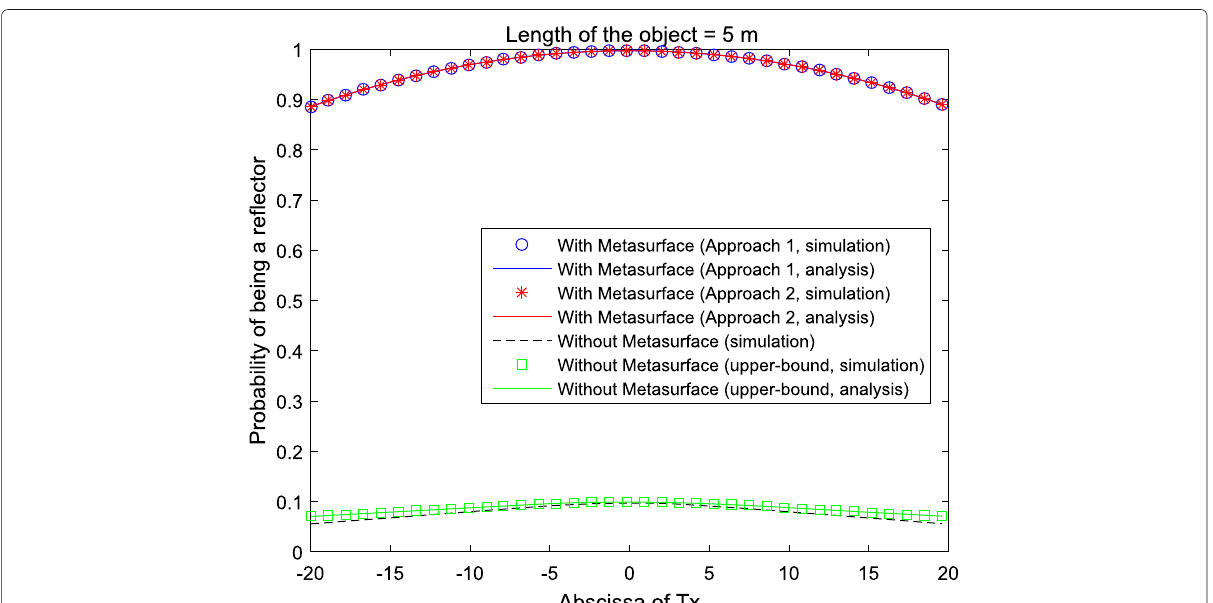
Fig. 8 Probability of being a reflector versus the horizontal location, x Tx , of the transmitter. Setup: R net = 30 m, vertical location of the transmitter y Tx = 3, location of the receiver ( 0,0 ) , length of the object L = 5 m